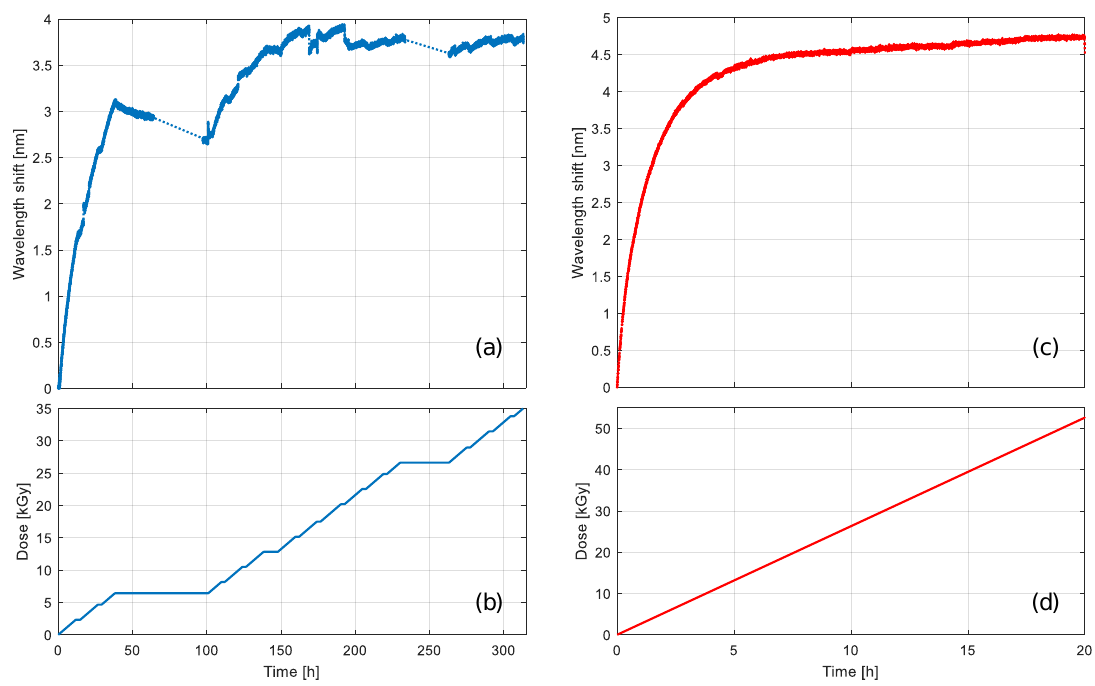
Figure 7. Real-time measurement of the LPGs during gamma irradiation: ( a ) wavelength shift and ( b ) irradiation profile using the industrial SVST Co-60 irradiator; ( c ) wavelength shift and ( d ) irradiation profile using the GC-5000 custom setup.